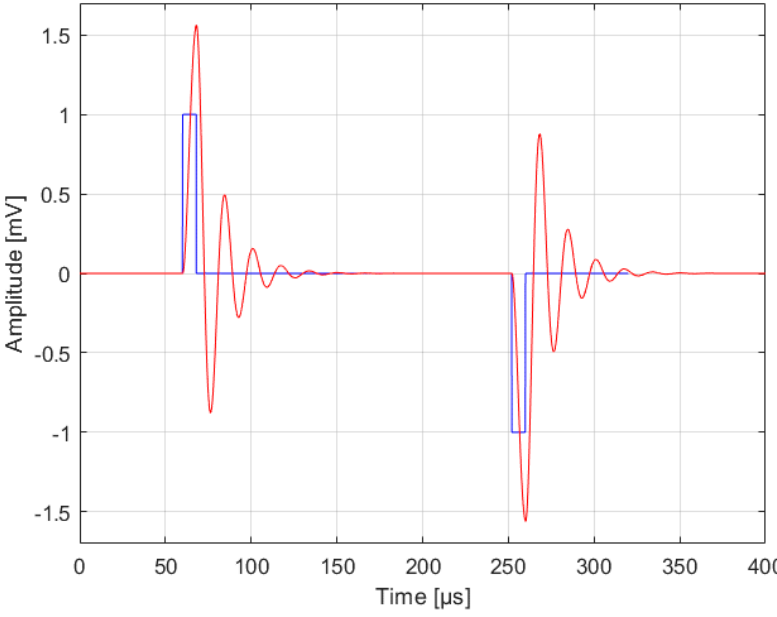
Figure 4. Electromotive force (EMF) pulse (blue line) and coil response (red line) obtained from a simulation of the equivalent RLC circuit model of the coil used for the experimental tests.